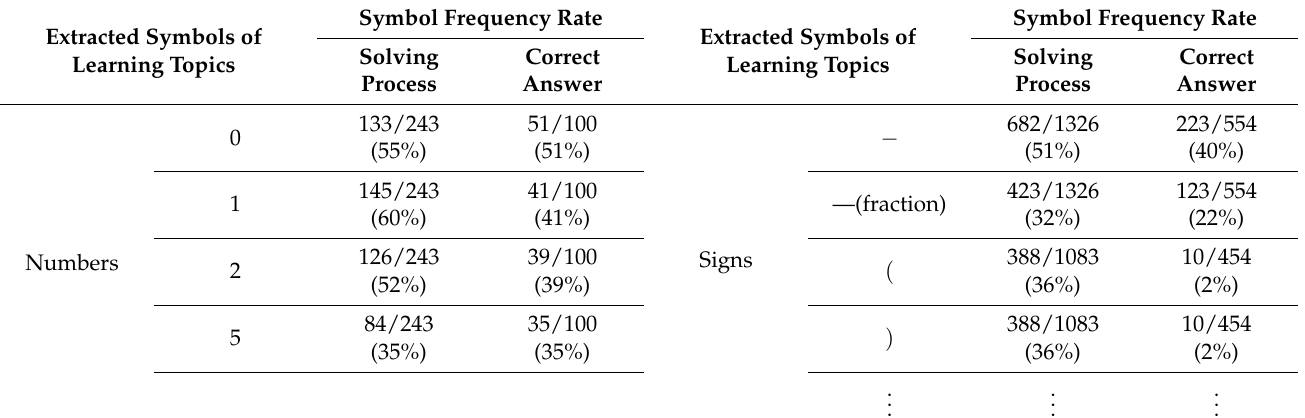
Table A3. Sample Symbol Frequency Rates in Solving Processes and Correct Answers for Symbols Extracted from Learning